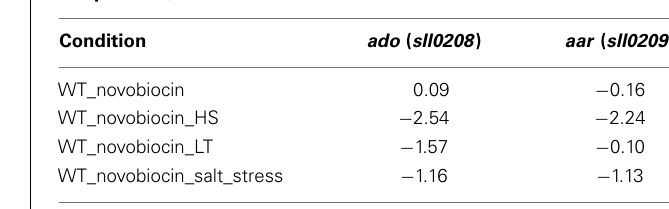
Table 1 | Log2 fold changes for ado and aar in Synechocystis 6803 after treatment with novobiocin in addition to heat stress, low temperature, and salt stress .